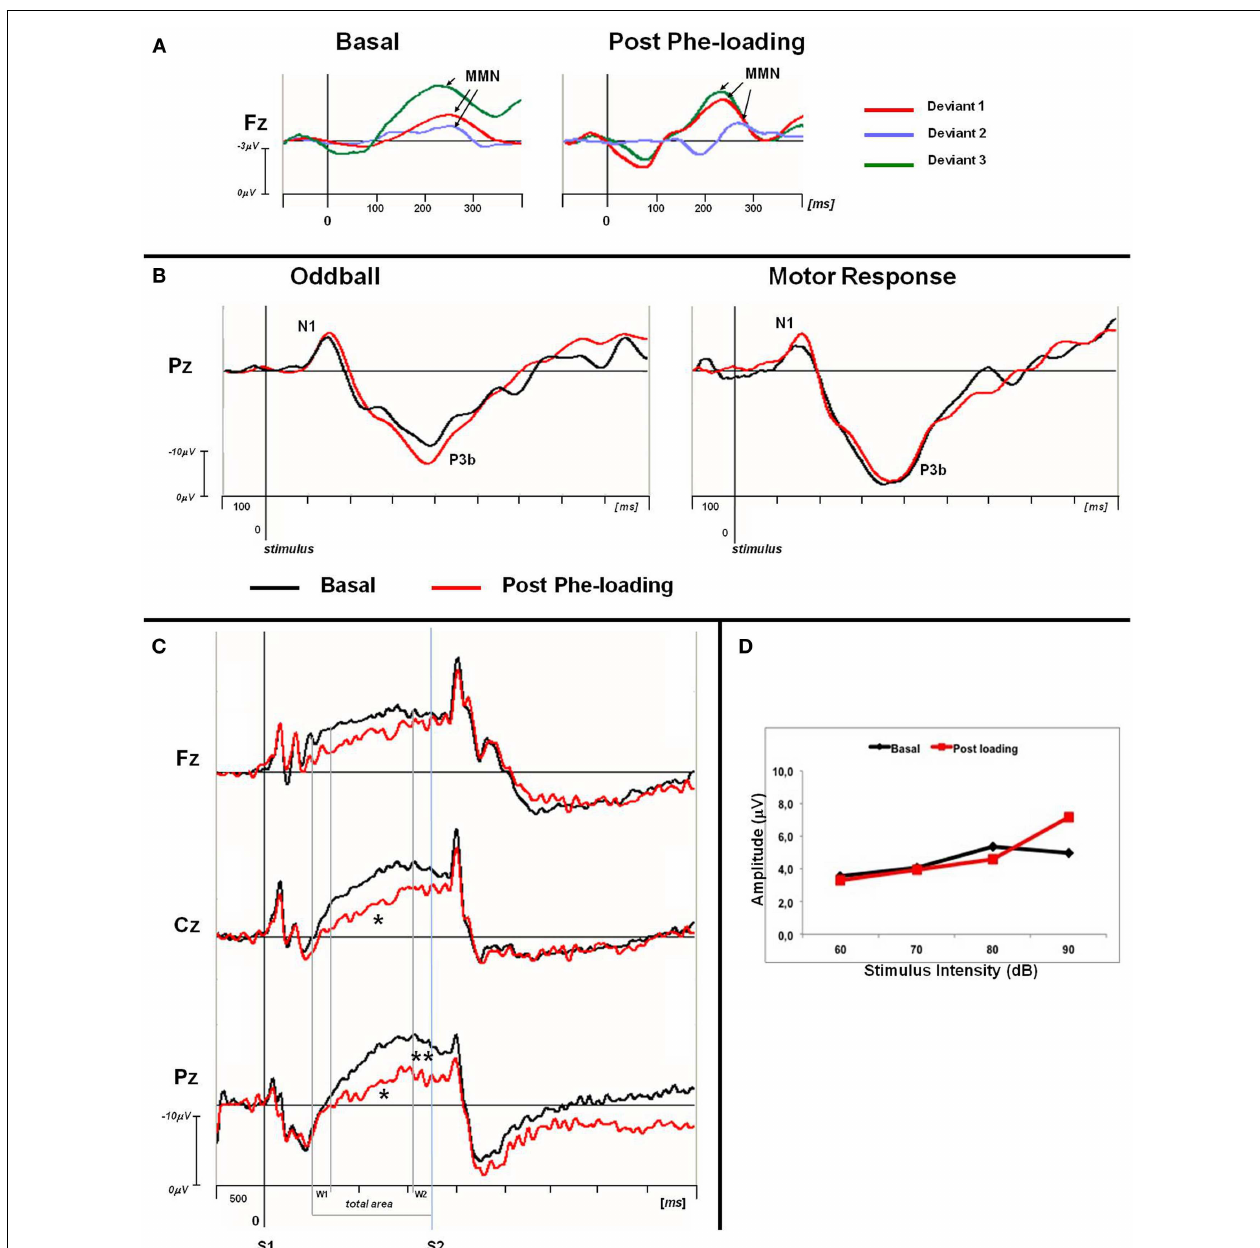
100ms pre-stimulus baseline. (C) Grand averaged CNV waveforms, with W1,W2, and total areas highlighted, superimposed at midline scalp sites for basal (black lines) and post-loading (red lines) evaluation.The epoch analysis is 5s, with a 500ms pre-stimulus baseline before S1. S1: warning stimulus (flash). S2: imperative stimulus (tone).The asterisks indicate statistical significant differences in CNV parameters (total area * p <